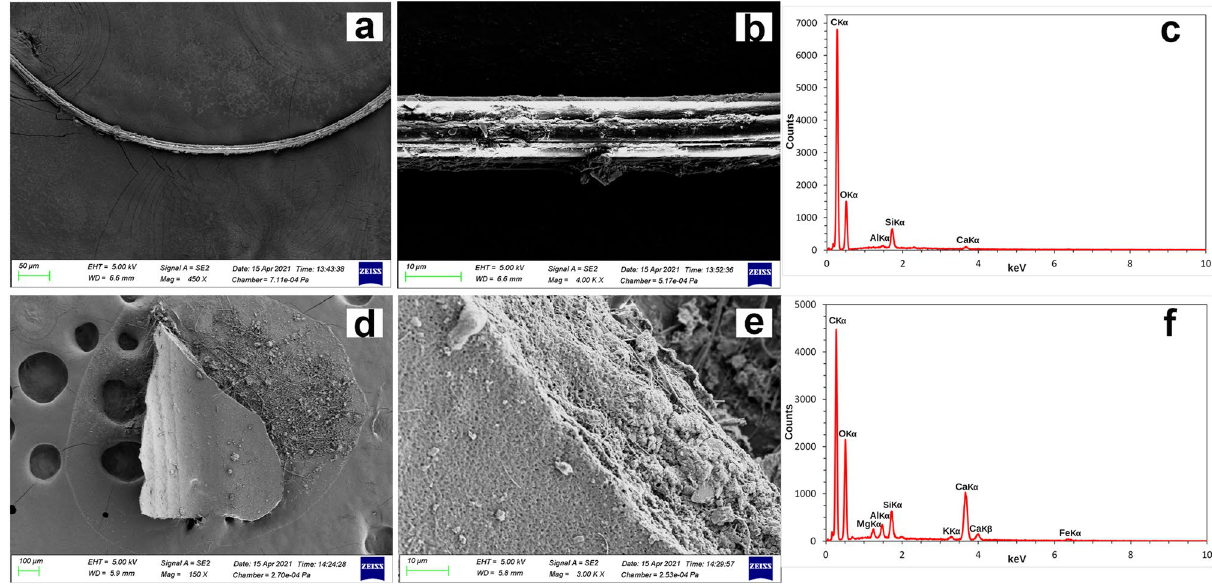
Figure 5. SEM/EDX images and microanalysis from canonical microplastic. SEM images ( a , b , d , f ) and EDX spectra ( c , f ) from a typical microplastic fibres ( a – c ) and typical microplastic debris ( d – f ) extracted from the stomachal content of the collected Bursatella leachii